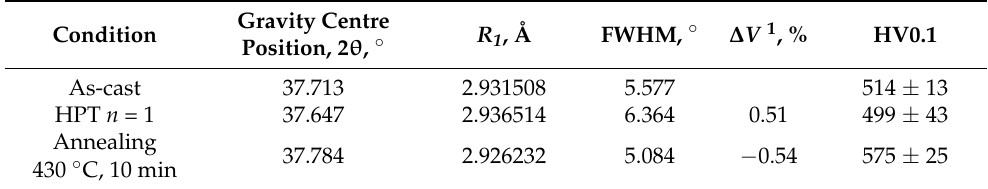
Table 1. Amorphous structure parameters in Vit105 BMG in various states: first amorphous halo gravity centre position 2 θ , radius of the first coordination sphere R 1 , full-width at half maximum (FWHM), change in free volume ∆ V , and microhardness HV0.1.